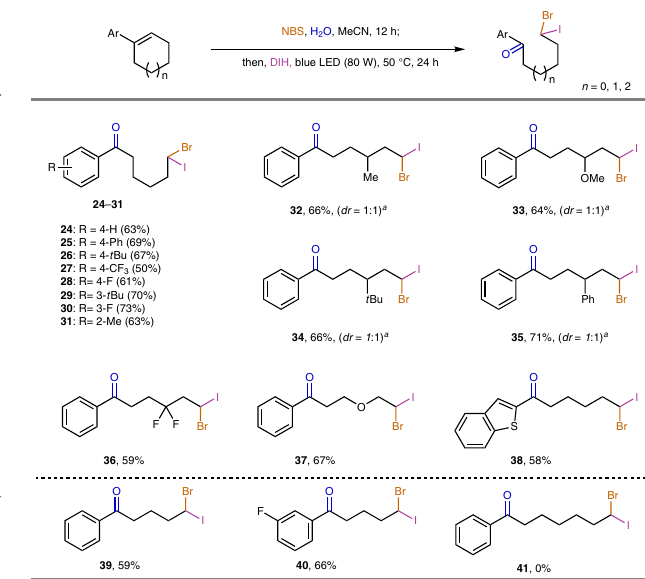
Fig. 3 Scope of oxidative deconstructive geminal bromo-iodination of cyclic alkenes. Isolated yields unless otherwise indicated. Performed